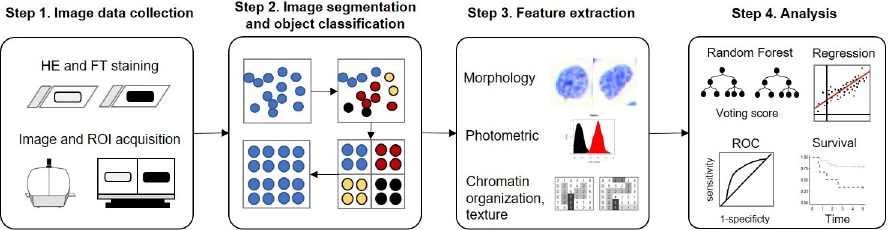
Fig 1. Study scheme. In Step 1, two consecutive 4- μ m tissue sections stained with hematoxylin-eosin (HE) and Feulgen-thionin (FT), respectively, are scanned and reviewed by an experienced pathologist to define the region of interests (ROIs) with ~3 x 3 mm 2 . In Step 2, the images of defined ROIs are segmented to classify objects into cell groups of which features are extracted to describe nuclear morphology, photometric, and chromatin organization and texture in Step 3. In Step 4, the features are used to build a patient classification model and compared with clinical- pathological data.